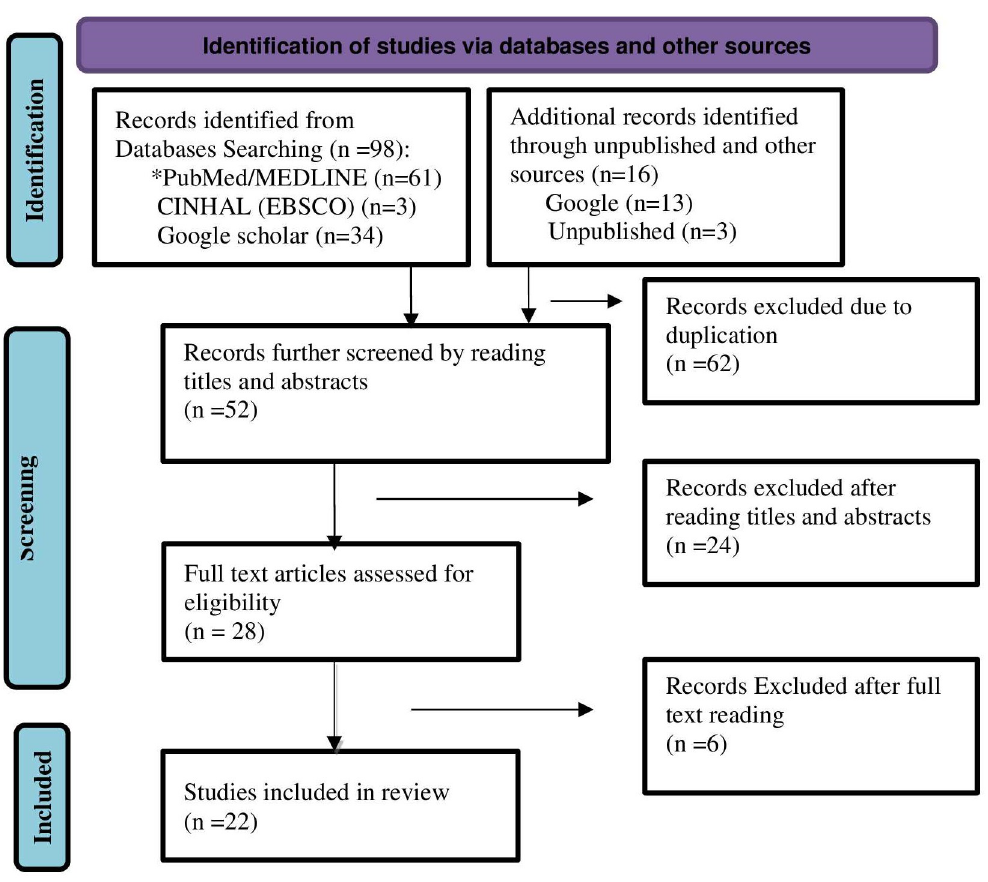
Fig 1. Description of schematic presentation of the PRISMA flow diagram, 2021. � During data base searching, automation tools were used; 23 records were excluded for not being human subject studies, 5 records were removed because full text was not available, and 1 record was removed because it was not a journal articles